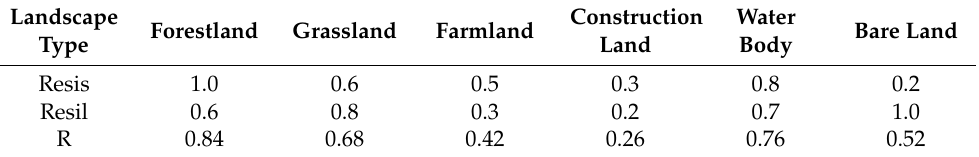
Table 2. The ecosystem resilience coefficient of each landscape type in Guiyang